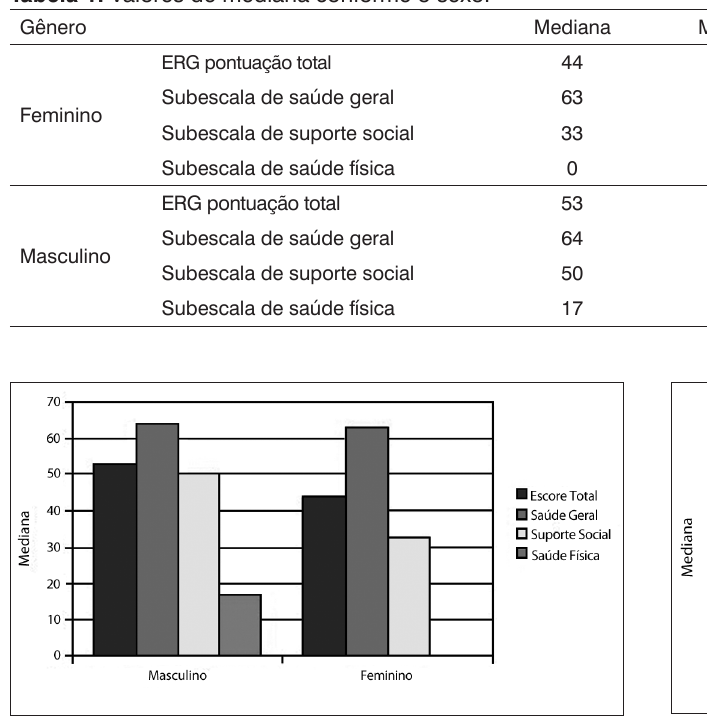
Gráfico 3. Valores da mediana conforme a